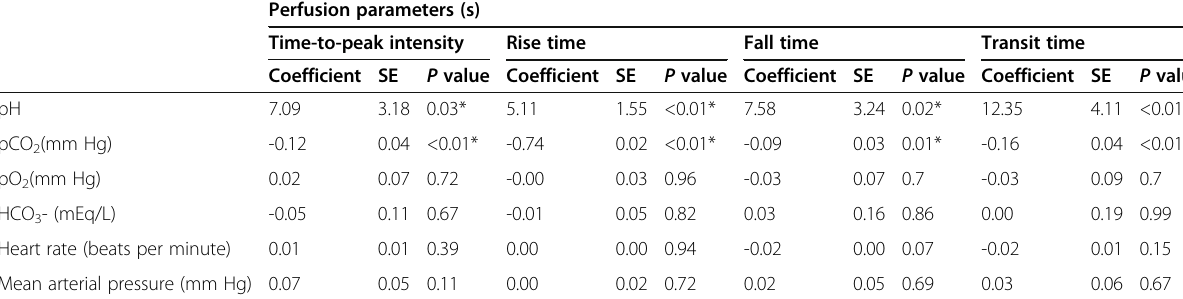
Table 2 Relationship between CEUS perfusion parameters and fetal variables (n=20 experiments)